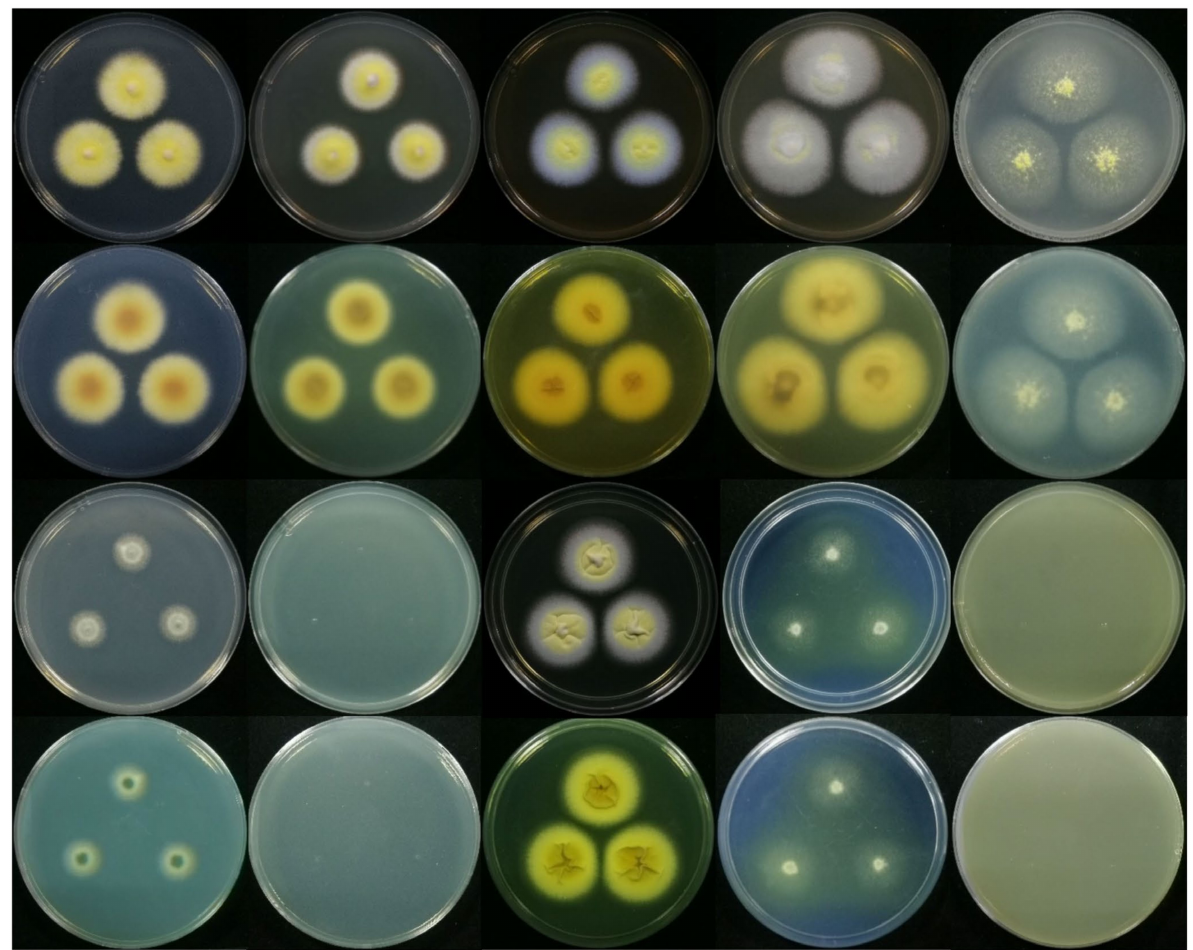
Figure 4. Macromorphological characters of strain JP-NJ4 (CCTCC M 2012167) (Inoculation at 25 ◦ C for 7 days). Colonies from left to right: (the top two rows) CZ, CYA, MEA, MEAbl, OA, and the reverse side corresponding to these media; (the bottom two rows) DG18, CYAS, YES, CREA, HAY, and the reverse side corresponding to these media (the background color is